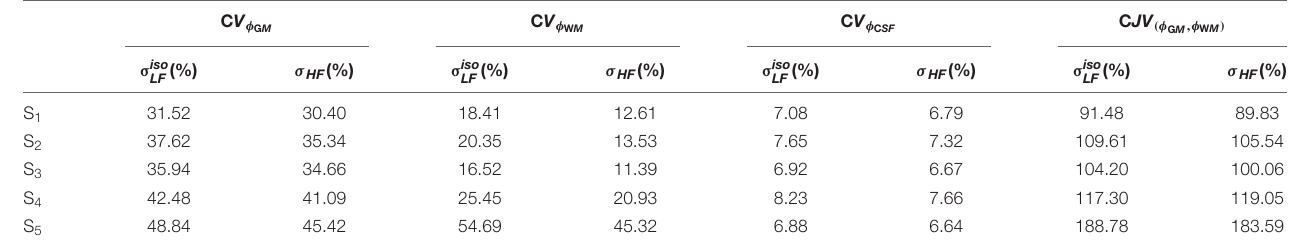
, CV φ , CV φ and CJV (φ GM WM CSF